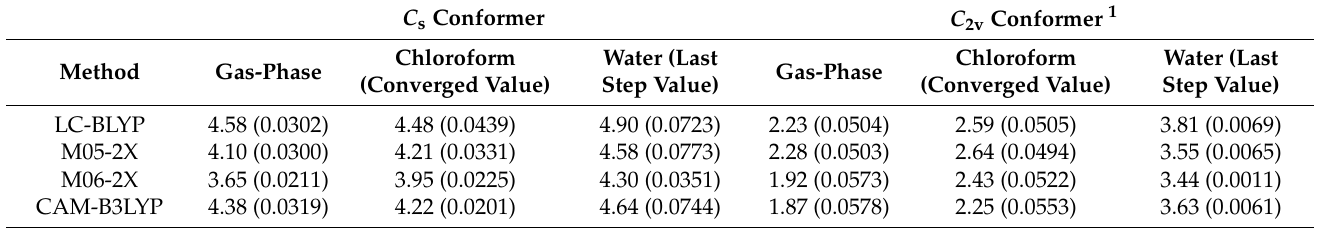
Table 4. TD-DFT results for excitation energy (in eV) and (oscillator strength) of the more intense electronic transition (considering the first 10 excited states) of the C s conformer in gas phase and in solution. For comparison, the results for the first electronic transition of the C 2v conformer are included. All results were obtained using the aug-cc-pVDZ basis